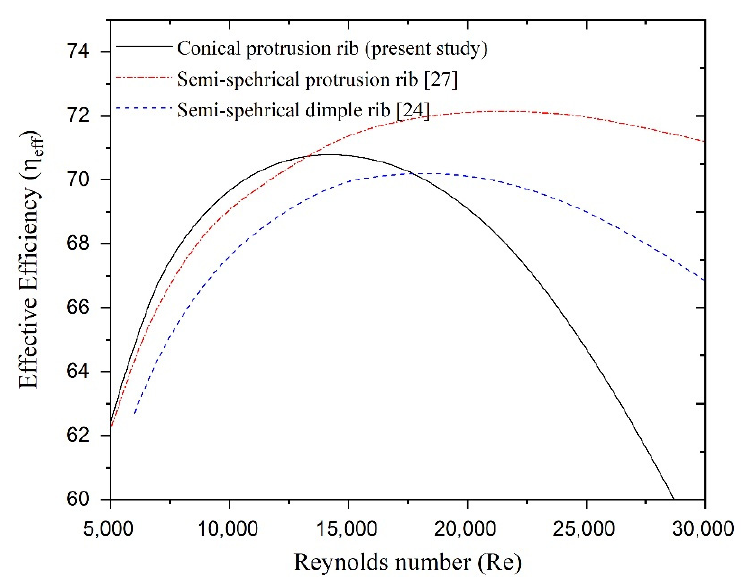
Figure 11. Comparison of net effective efficiency with similar roughnesses.